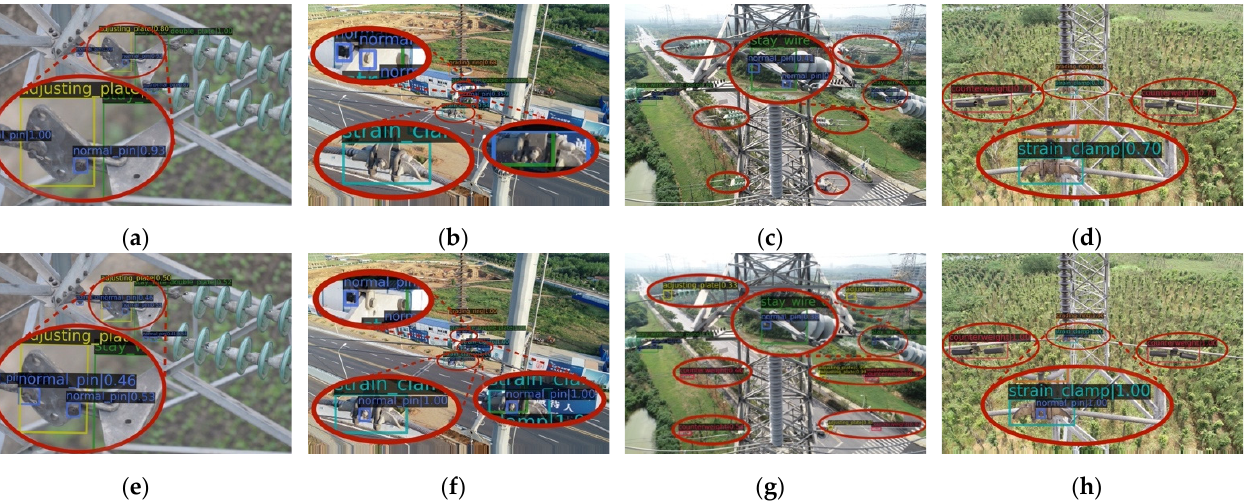
Figure 11. Visual results of the detected object by Dynamic ATSS and CIE-JHR method. ( a ) Insula- tor string and tower connection based on Dynamic ATSS algorithm, ( b ) strain clamp scene based on Dynamic ATSS algorithm, ( c ) multiple insulator string and tower connection based on Dynamic ATSS algorithm, ( d ) strain clamp and counterweight scene based on Dynamic ATSS algorithm, ( e ) insulator string and tower connection based on CIE-JHR method, ( f ) strain clamp scene based on CIE-JHR method, ( g ) multiple insulator string and tower connection based on CIE-JHR method, ( h ) strain clamp and counterweight scene based on CIE-JHR method.